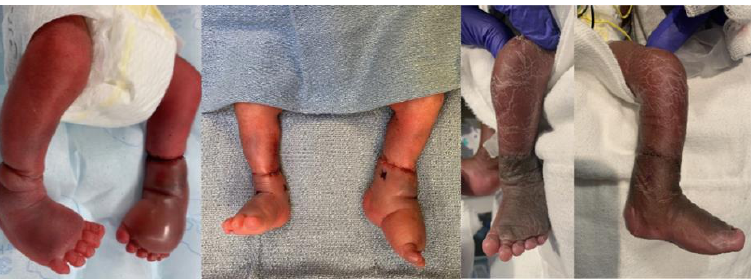
Figure 5. Clinical photos of Patient 3: preoperative, intraoperative, and 1-year postoperative.